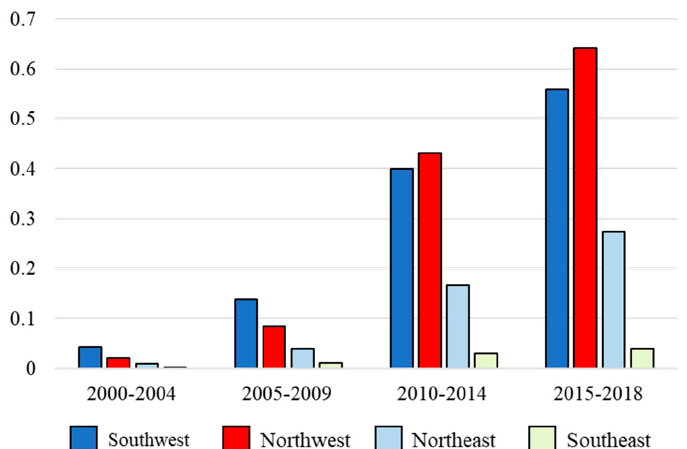
Figure 4. Evolution of the average innovation capacity of the secondary industry of the units in each area in Shenzhen from 2000 to 2018.